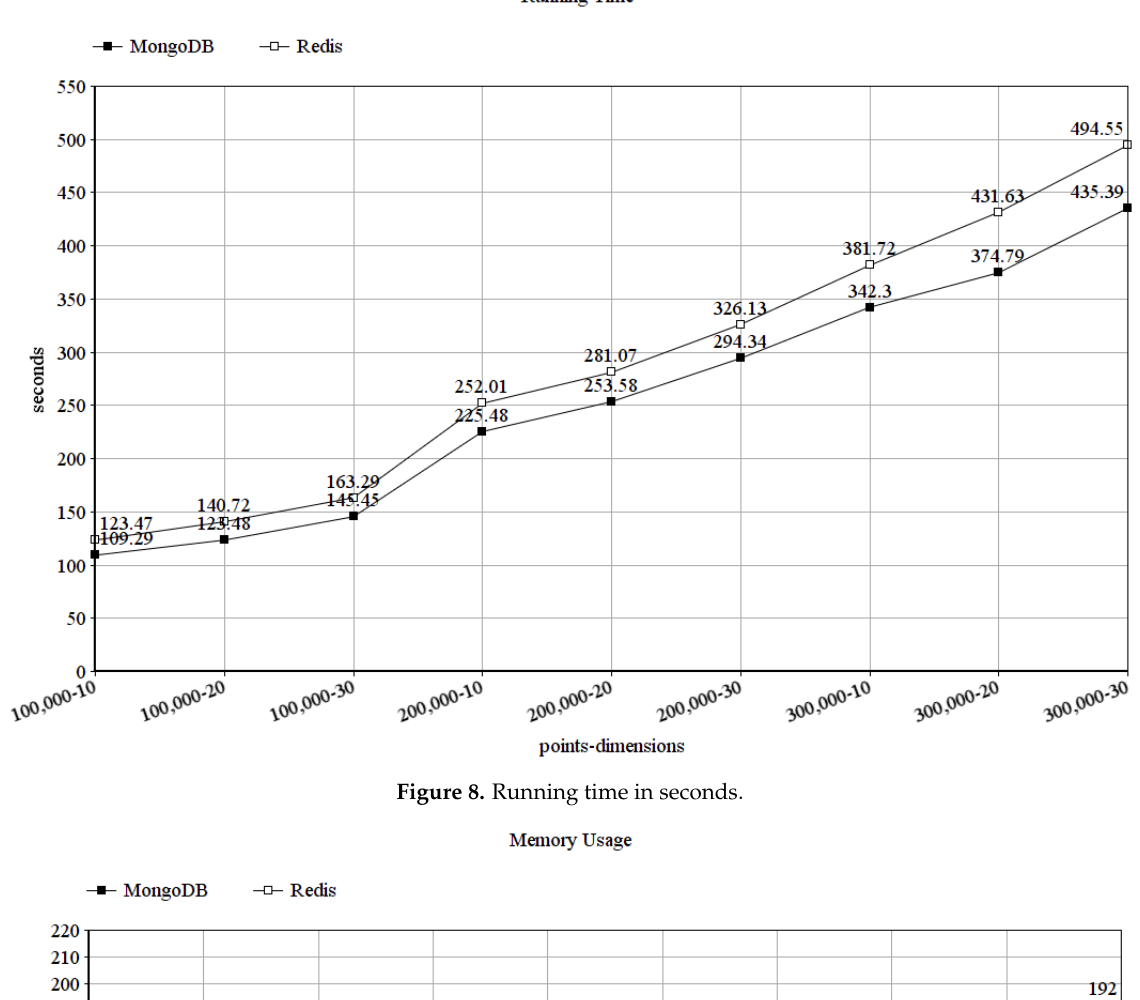
Figure 8. Running time in seconds.